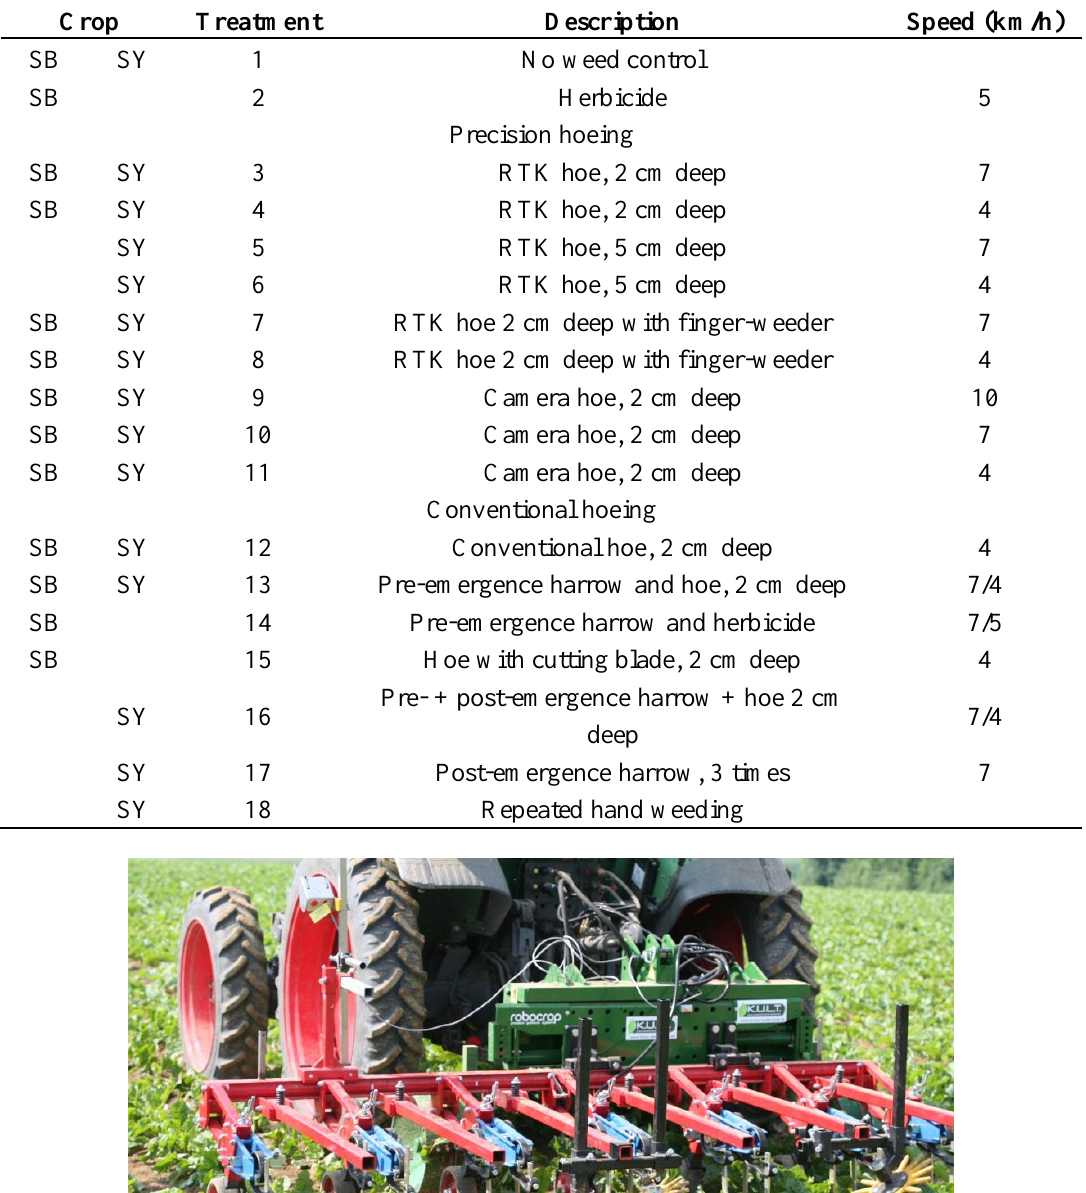
Table 1. Description of experimental treatments investigated in soybean (SY) 2013/2014 and sugar beet (SB) in 2014.